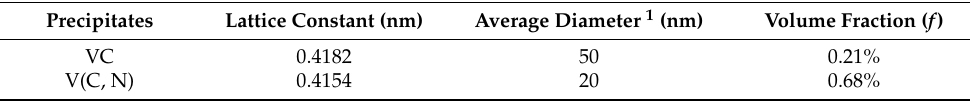
Table 4. Parameters of VC and V(C, N) in the tested samples.